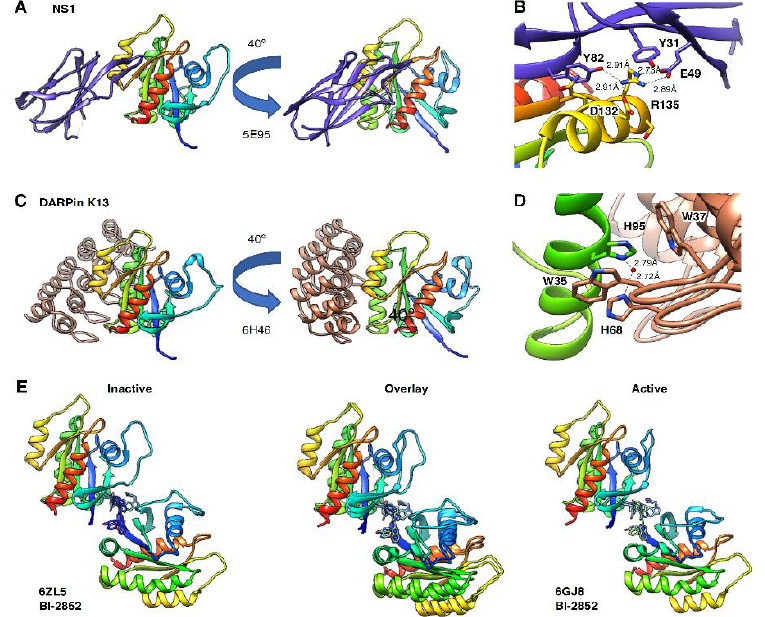
Figure 8. RAS in complex with exogenous molecules that interfere with dimer formation. ( A ) Monobody NS1 in complex with HRAS binds at the α 4– α 5 interface. (B) Key interactions between HRAS R135 and residues on NS1, including E49. ( C ) Antibody mimetic DARPin K13 in complex with KRAS binds at the α3–α4 interface. ( D ) Key interactions between KRAS H95 and key residues on DARPin K13, including a water-mediated interaction. ( E ) Small molecule BI-2852 in complex with inactive (left) and active (right) KRAS, which binds at the β1 switch 2 interface. RAS is shown as a ribbon colored by sequence with cold colors at N-terminus and hot colors at the C-terminus.